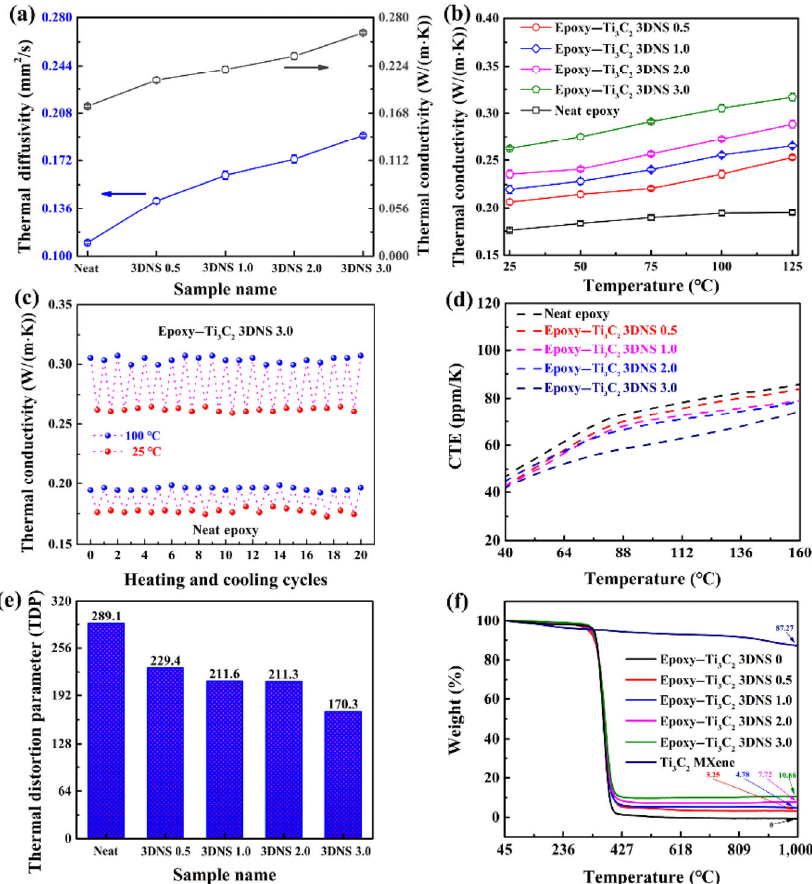
Fig. 5 Thermal performance of epoxy resin and epoxy–Ti 3 C 2 3DNS composites: (a) thermal diffusivity and TC, (b) TC at different temperatures, (c) TC under heating and cooling cycle, (d) CTE curves, (e) TDP curves, and (f) TGA